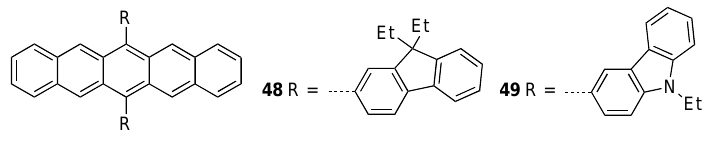
Figure 5. Structures of 6,13-bis(9,9-diethyl-9 H -fluoren-2-yl)pentacene ( 48 ) and 6,13- bis(9-ethyl-9 H -carbazol-3-yl)pentacene ( 49 ).